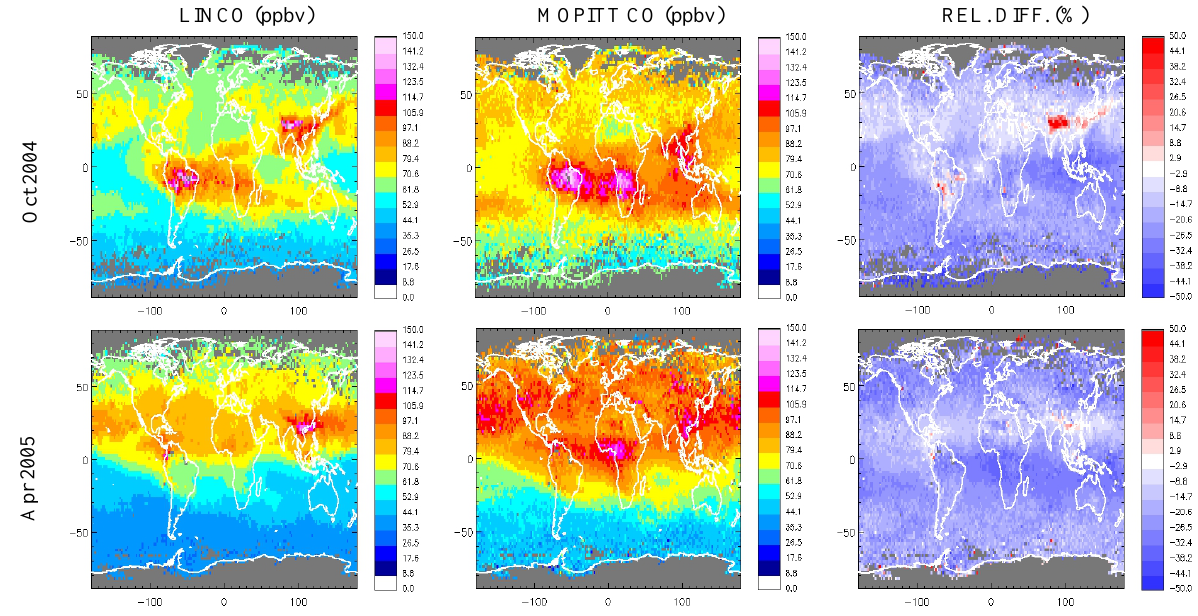
Fig. 6. Same as Fig. 5 but for